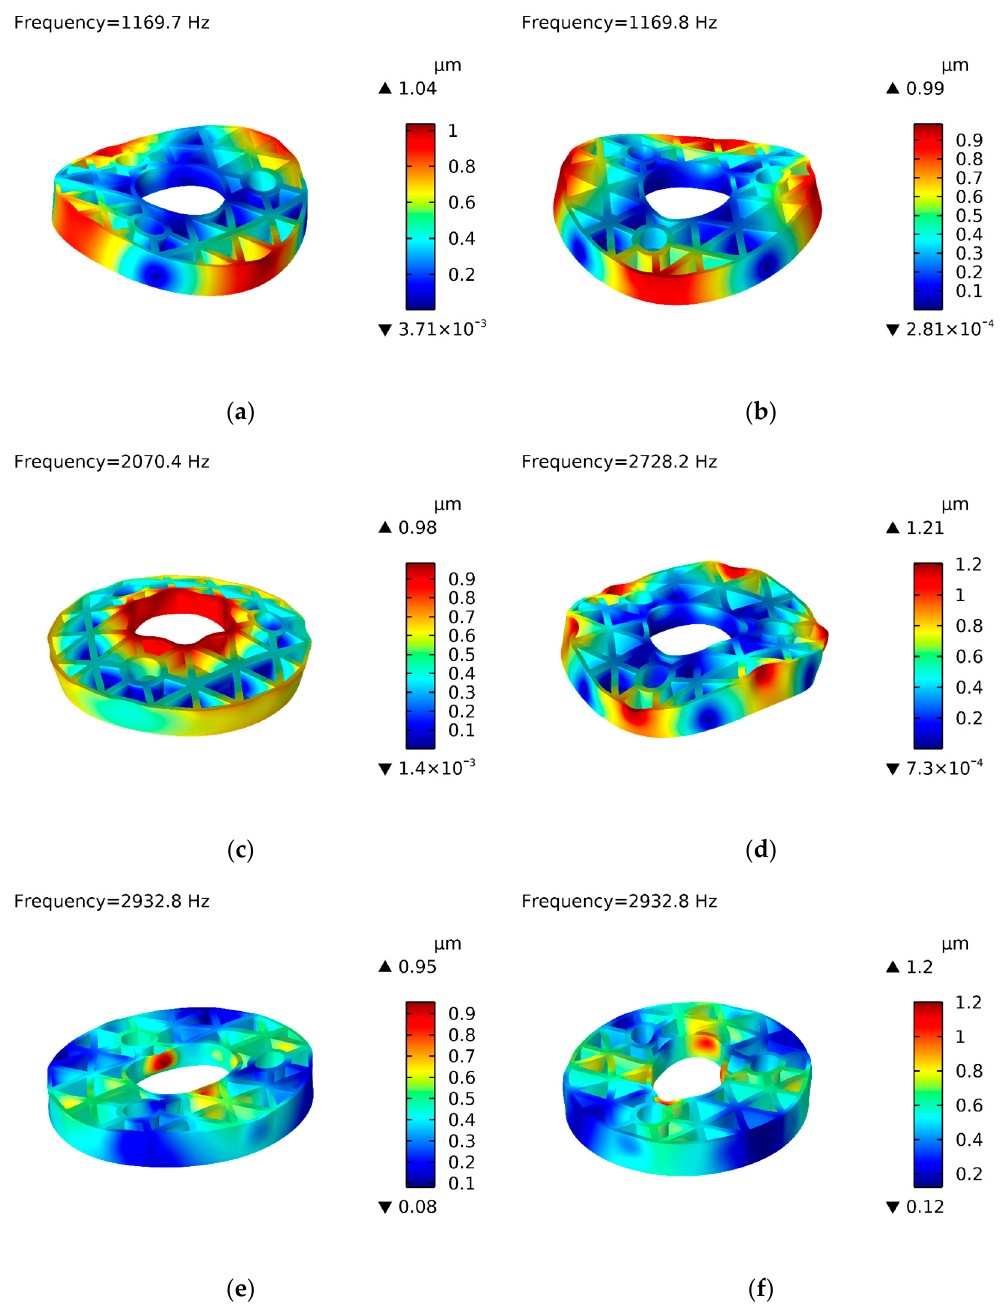
Figure 3. Free mode analysis of the 1st − 6th order of the initial mirror. ( a ) The first free mode shape; ( b ) The second free mode shape; ( c ) The third free mode shape; ( d ) The fourth free mode shape; ( e ) The fifth free mode shape; ( f ) The sixth free mode